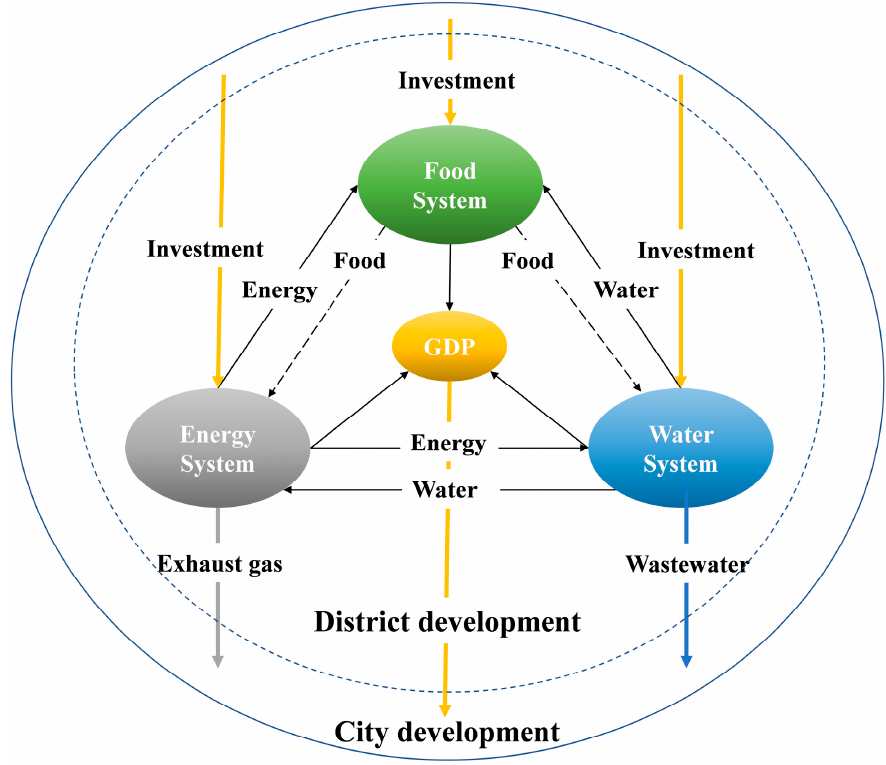
Figure 2. Conceptual framework of an urban FEW system towards economic development. (Dash line meaning that no actual food production link to energy and water systems, and the relationships among them indicate that food consumption accounting in food system include those in energy and water systems). Table 2. The outline of the input and output indicators for urban FEW efficiency